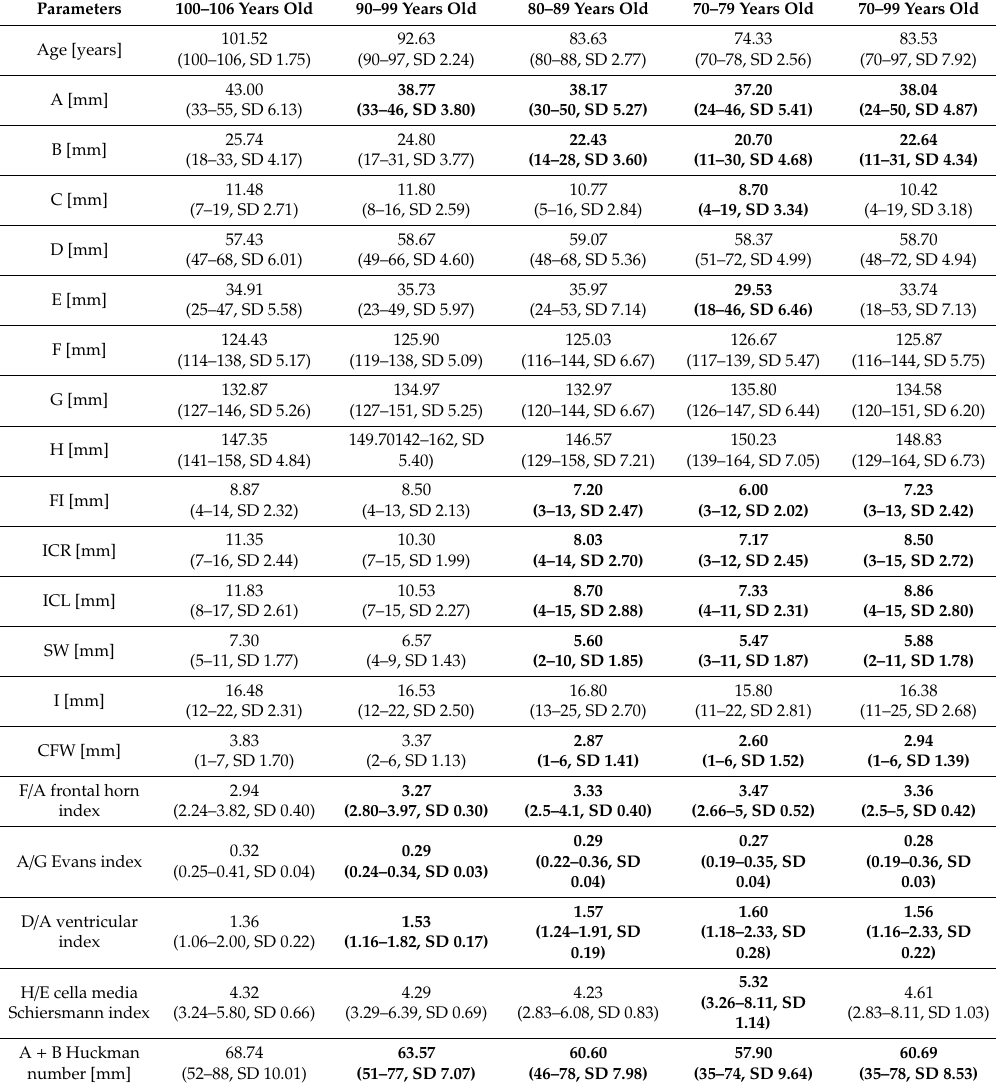
Table 1. Mean values of brain atrophy parameters and indices in the consecutive age